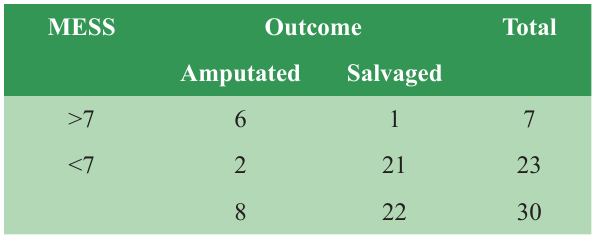
Table1: Number of amputated and salvaged limbs